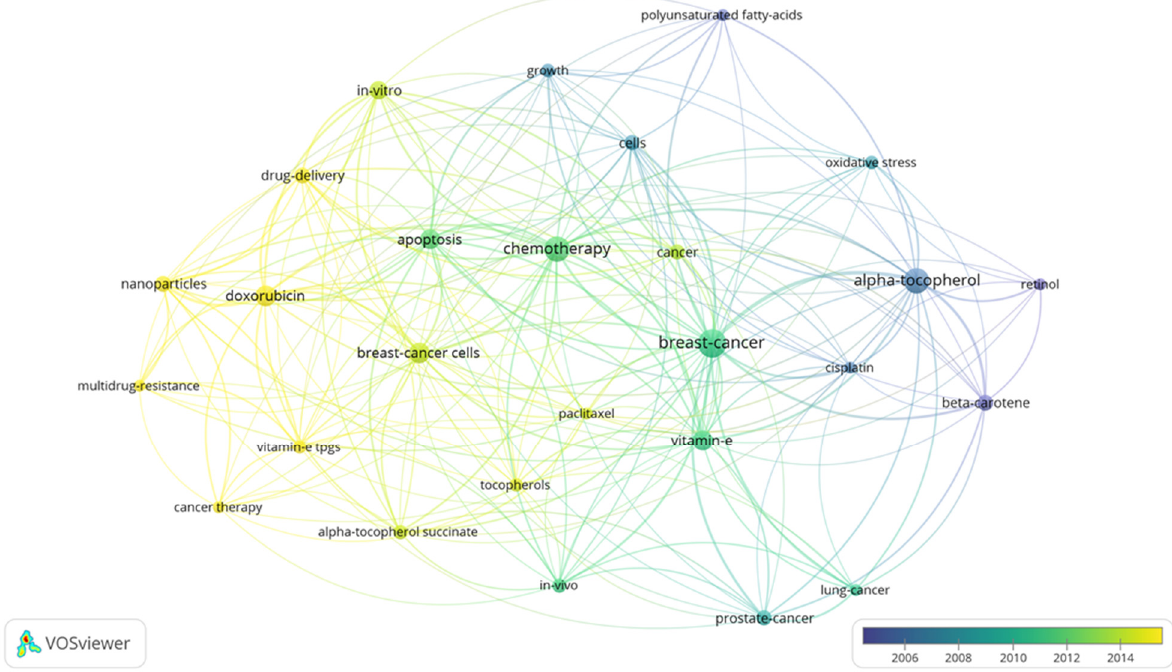
Figure 6. Term map for years 2005–2015 generated from Search 4. Visualization of 27 terms that occurred a minimum of 5 times in publications. Table S5 lists the visualized terms and their respective occurrences, average year of publication, and average number of citations.